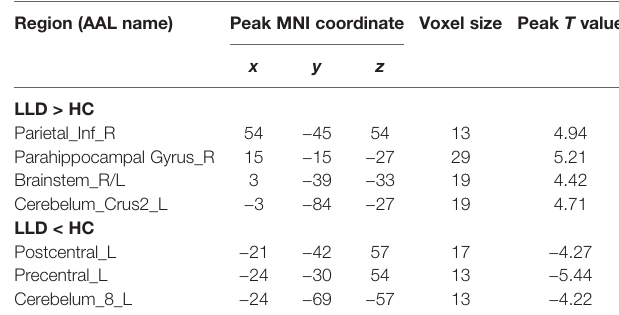
TABLE 2 | Brain areas showing different DC between LLD patients and HCs ( p < 0.05,